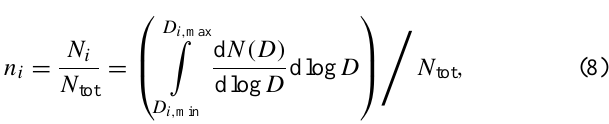
measurements were available at the same time. The